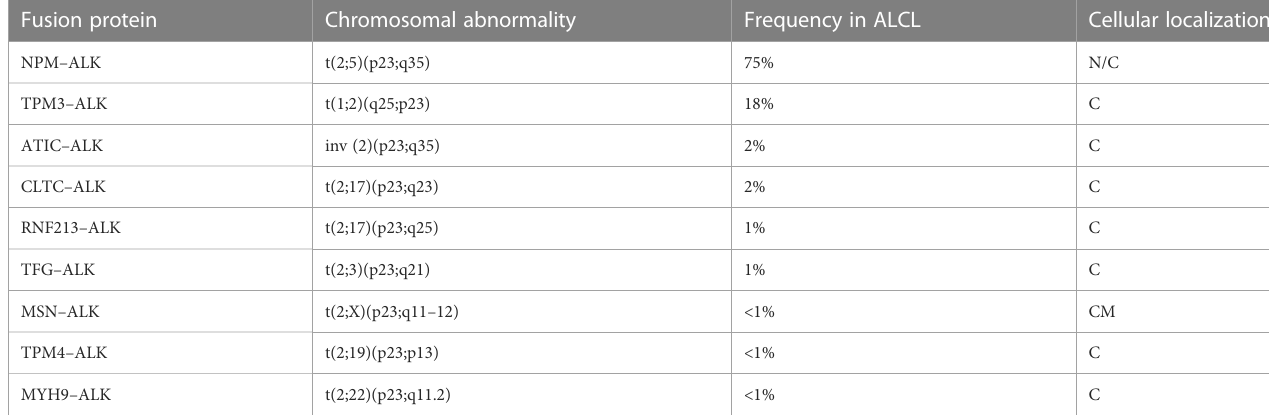
TABLE 1 Commonest chromosomal translocations involving ALK gene in ALCL. Fusion protein Chromosomal